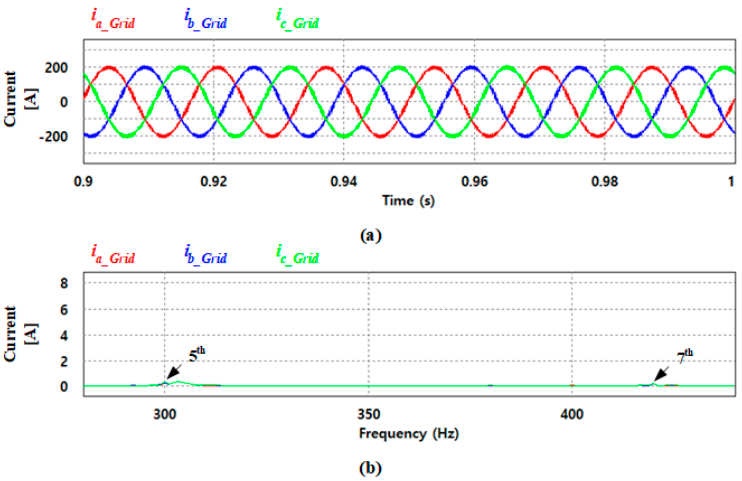
Figure 15. Simulation waveforms when applying the SHE method: ( a ) output current, ( b ) FFT analysis result. Table 6. Performances of the SHE method for different the bandwidths.